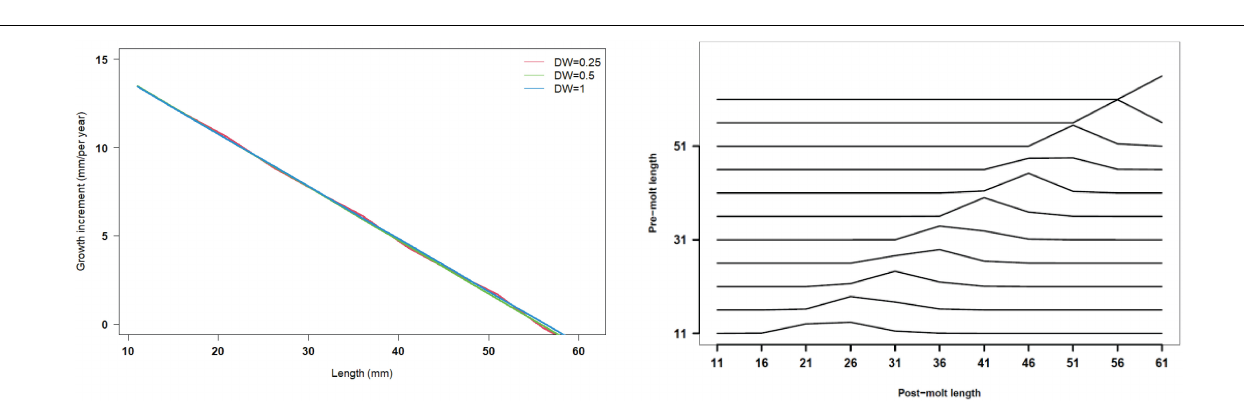
FIGURE 9 | Length increment per year at length and size transition matrix under three kinds of data weightings (red line present weights in 0.25, green line present weight in 0.5, blue line present weight in